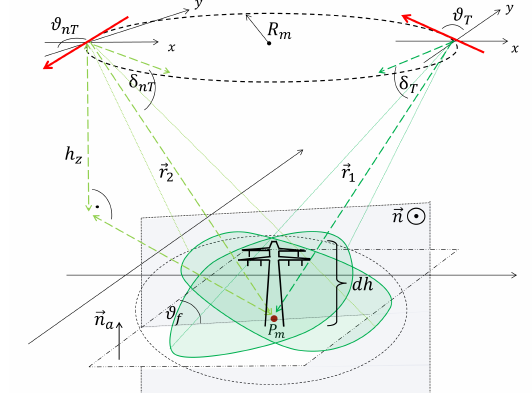
Figure 3. Representation of two different views by overlapping beams on a vertical target in CSAR geometry. The design of the vertical focusing plane with normal vector (cid:126)n is indicated in blue.